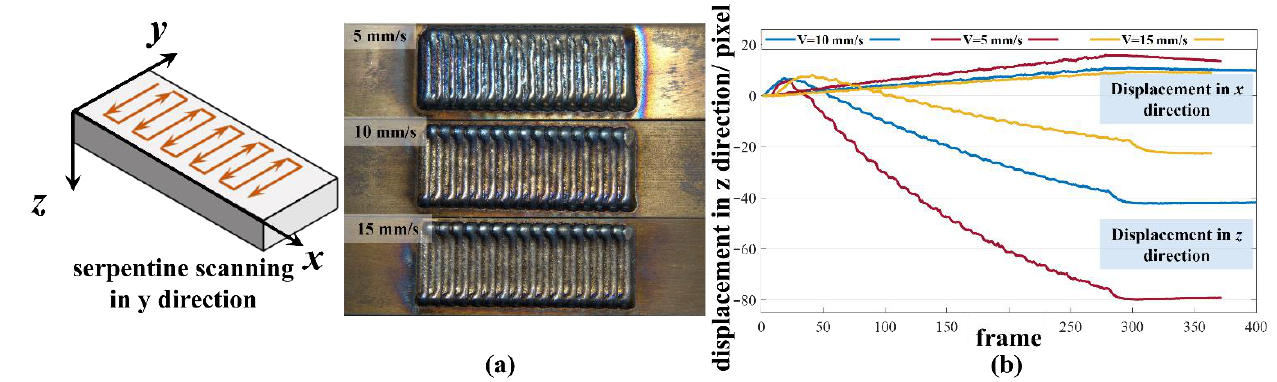
Figure 13. ( a ) The cladding results at different scanning speeds and ( b ) the displacement evolution at different scanning speeds.